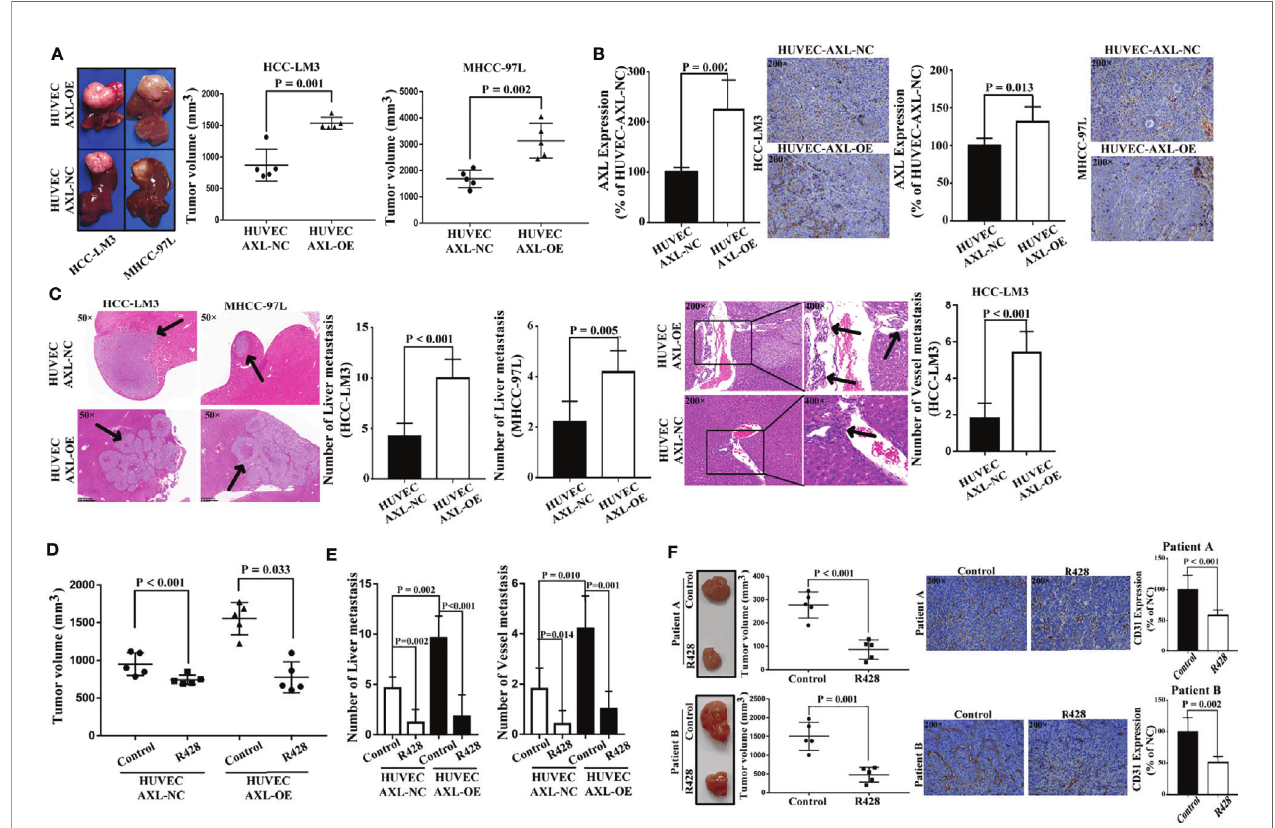
FIGURE 7 | HUVECs overexpressing AXL promote tumor growth and metastasis of HCC in vivo . (A) HUVECs overexpressing AXL promoted tumor growth in vivo (HCC-LM3: p = 0.001; MHCC-97L: p = 0.002). (B) AXL was highly expressed in the vessels of the HUVEC-AXL-OE group compared with the HUVEC-AXL-NC group (HCC-LM3: p = 0.002; MHCC-97L: p = 0.013). (C) HUVECs overexpressing AXL promoted vessel metastasis and liver metastasis of HCC-LM3 cells in vivo , and HUVECs overexpressing AXL, but not HUVEC-AXL-NC cells, induced liver metastasis and vessel metastasis of MHCC-97L cells in vivo . (D) R428 treatment decreased tumor volume induced by HUVECs overexpressing AXL and HCC-LM3 cells or MHCC-97L cells. (E) R428 treatment decreased vessel metastasis and MVI of HCC induced by HUVECs overexpressing AXL and HCC-LM3 cells or MHCC-97L cells. (F) R428 treatment decreased tumor volume in the HCC PDX models (patient A: p < 0.001; patient B: p = 0.001). Furthermore, in the HCC PDX models, CD31 expression in the tumors of mice treated with R428 was lower compared with that in the tumors of mice treated with the control (patient A: p < 0.001; patient B: p =